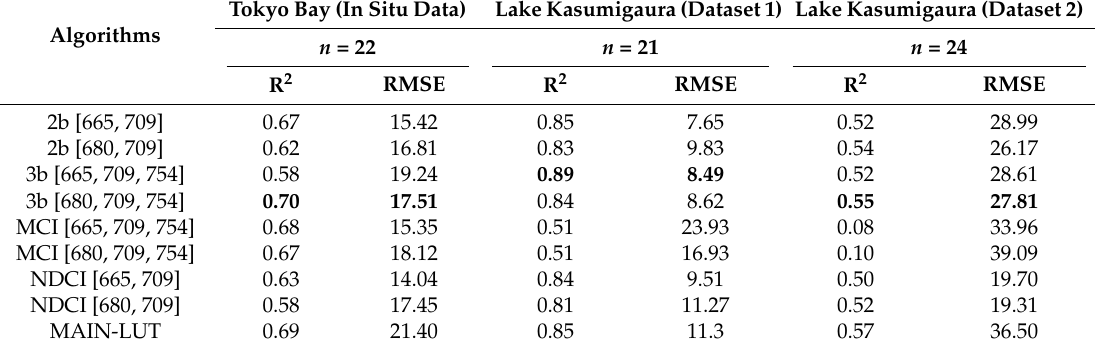
Data highlighted in bold represents the best algorithm performance with the highest R 2 during the calibration stage. Lake Kasumigaura Datasets 1 and 2 represent measurements collected in 2016 and during 2002–2012, respectively. a 0 , and a 1 represent slope and intercept for linear regression approach. The variable “ N ” denotes the number of samples used during the calibration stage. Table 6. Algorithms’ retrieval accuracies during the validation stage using MERIS data.